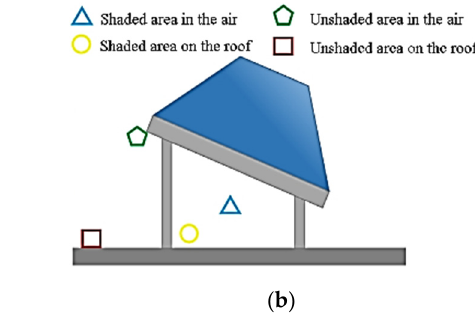
Figure 2. ( a ) Photograph and ( b ) schematic of the sensing positions on the photovoltaic roof.